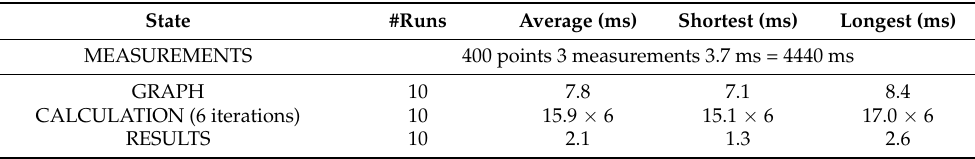
Table 1. Profile